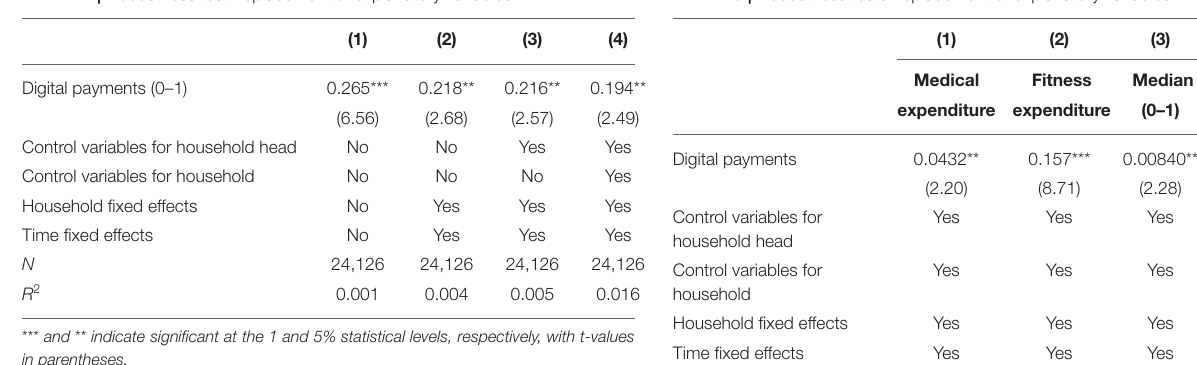
TABLE 4 | Robustness test: replacement of explanatory variables. TABLE 5 | Robustness tests: replacement of explanatory